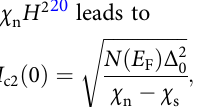
Fig. 4 Ising superconductivity in single-layer and few-layer TaS 2 and NbSe 2 . a Parallel upper critical fi eld normalized to Pauli paramagnetic limit, H jj a function of reduced temperature T / T c0 for monolayer (1L), trilayer (3L), four-layer (4L), and fi ve-layer (5L) TaS 2 samples, and b monolayer (1L, from Xi et al. 4 ) and bilayer (2L) NbSe 2 . Dashed lines show the square-root fi t described in the main text. c Illustration of spin states along intersection Fermi surface and line of high symmetry from 1L TaS 2 , experiencing varying B so ( k ) throughout Brillouin zone. Spin projections indicated by color. Dashed line marks the envelope of B so along K ′ – Γ – K. d Schematic Fermi surface of multilayer TaS 2 ignoring interlayer coupling, t ⊥ , showing opposite B so in neighboring layers due to inversion of crystal fi eld between layers. e Ratio of interlayer coupling energies to spin – orbit coupling strength t ⊥ / Δ so as a function of the number of layers for TaS 2 and NbSe 2 extracted from density functional theory, with Δ TaS 2 guides to the eye. f Dependence of the reduced upper critical fi eld h c2 (cid:3) H jj NbSe 2 data from Xi et al. 4 . Data are normalized by the reduced upper critical fi eld of a monolayer h ð 1L Þ with density of states at the Fermi level N ( E F ), BCS gap Δ 0 , and susceptibilities in the normal and superconducting states, χ n , χ s . For a spin-singlet superconductor without spin – orbit coupling,